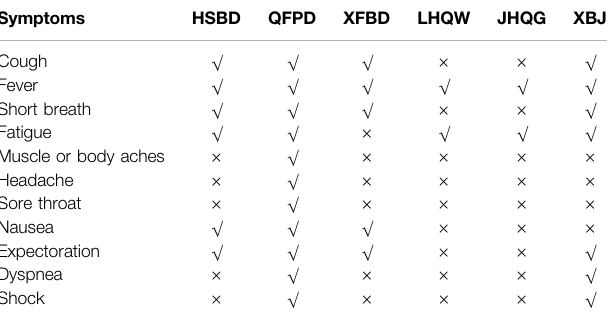
TABLE 2 | Application of TCM against different symptoms of COVID-19 recommended by China National Health Commission (NHC) (National